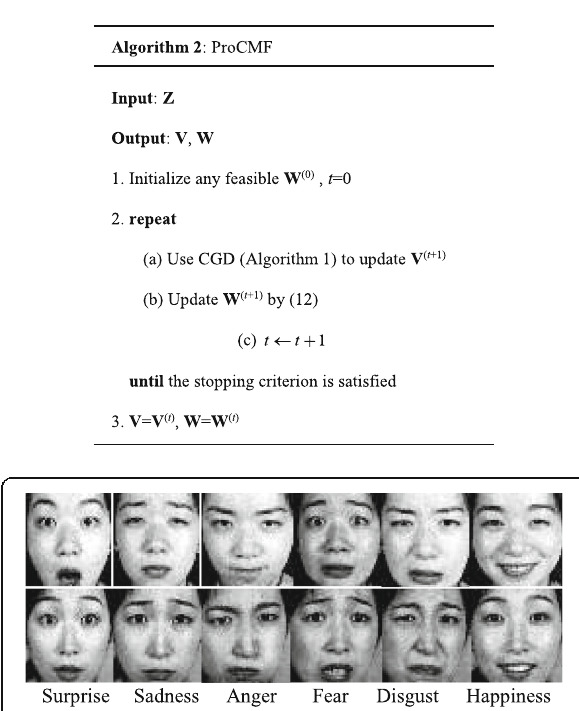
Fig. 4 Reconstructed images by a NMF, b proNMF, and c the proposed proCMF from the JAFFE dataset